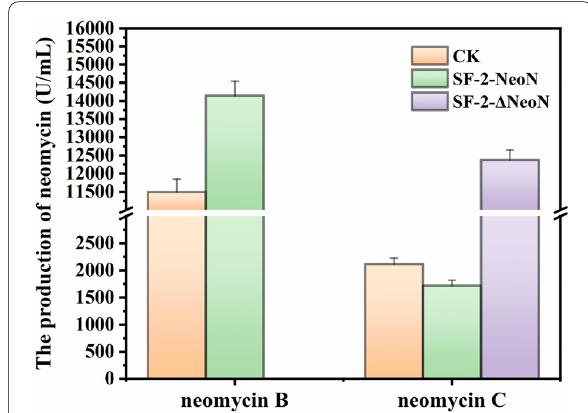
Fig. 3 Production of neomycin B and neomycin C by strains SF-2, SF-2-NeoN, and SF-2ΔNeoN during